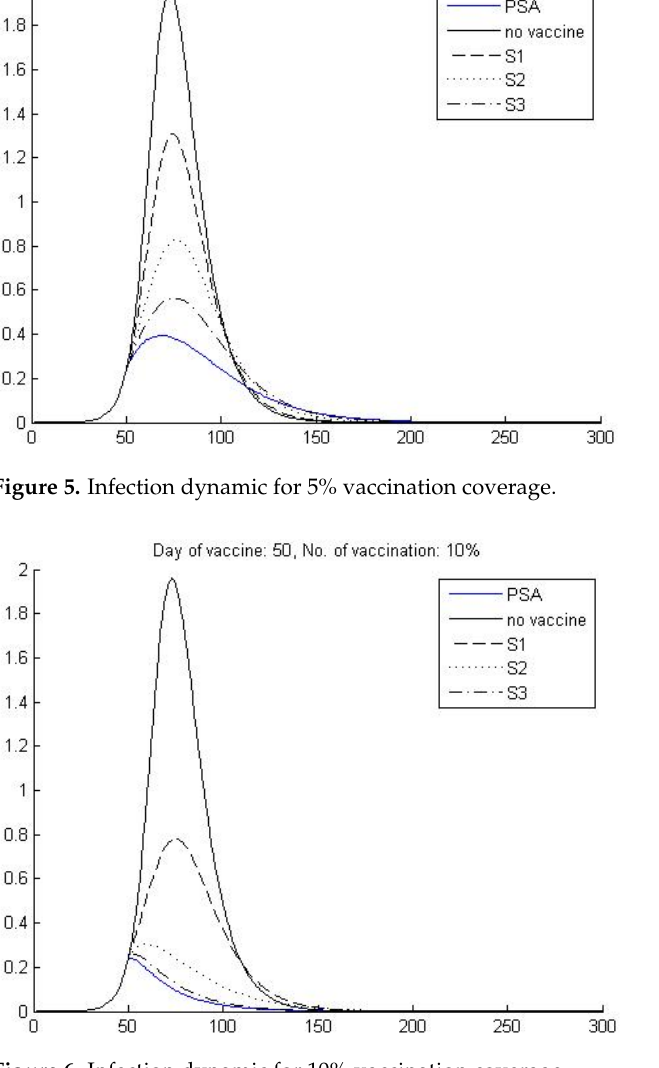
Figure 6. Infection dynamic for 10% vaccination coverage.